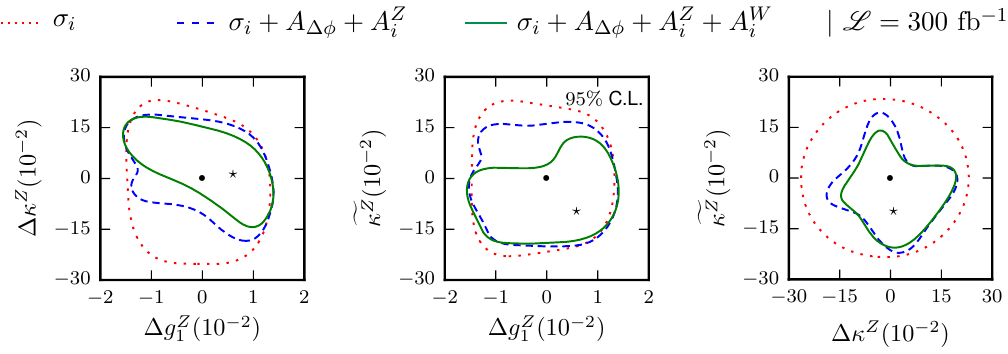
Figure 11 . The marginalised 2 D projections at 95 % BCI on (cid:1) g Z